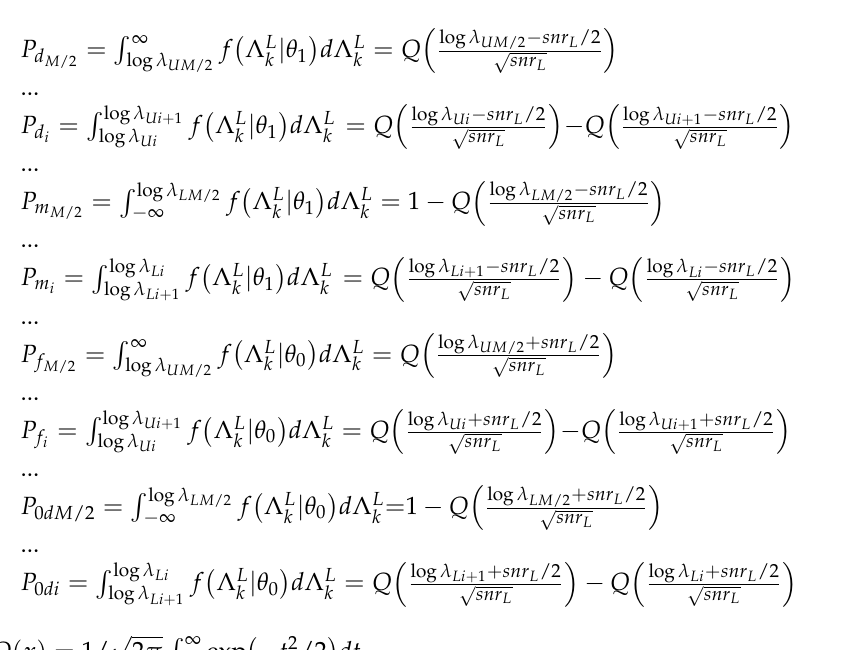
M -bit symbols in the set of 2 = P ( s ) } ( i ∈ | θ 1 i + M /2 i = P ( s ) } ( i ∈ [ 1, M /2 ]) , the | θ m i 1 M /2 − i + 1 = P ( s ) } ( i ∈ [ 1, M /2 ]) and the detection prob- | θ 0 i + M /2 i = P ( s ) } ( i ∈ [ 1, M /2 ]) . Then, | θ 0 M /2 − i + 1 i